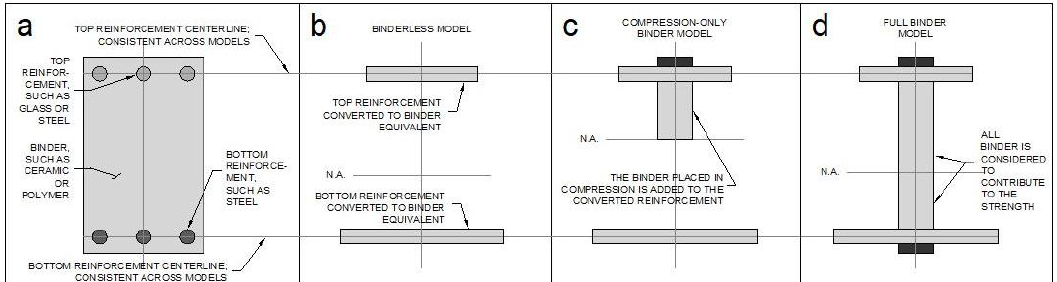
Figure 6. A summary of the binder models considered. ( a ) The general arrangement of the beams considered. ( b ) The binderless model, where the reinforcement is converted to binder-material; due to the differential Young’s moduli between the materials. ( c ) The compression-only binder model, which is commonly used for the concrete design. ( d ) In cases where the binder still contributes significantly to the beam’s flexural stiffness, the full binder model may need to be used. Note the dark gray regions at the top (c and d) and bottom (d), which denotes cover regions. These small components contribute little strength, with the true intention being protection for the reinforcement.